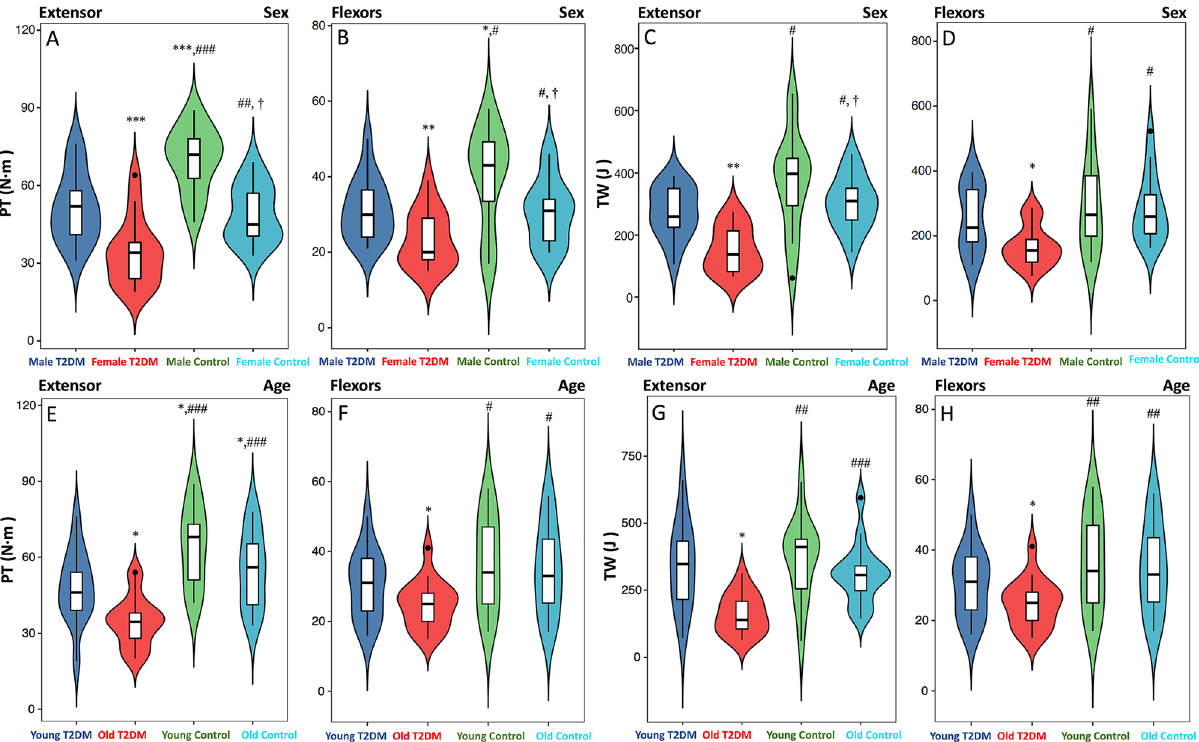
## p < 0.01, ### p < 0.001, vs. Female/Old T2DM patients. † p < 0.05, vs. Male/Young control